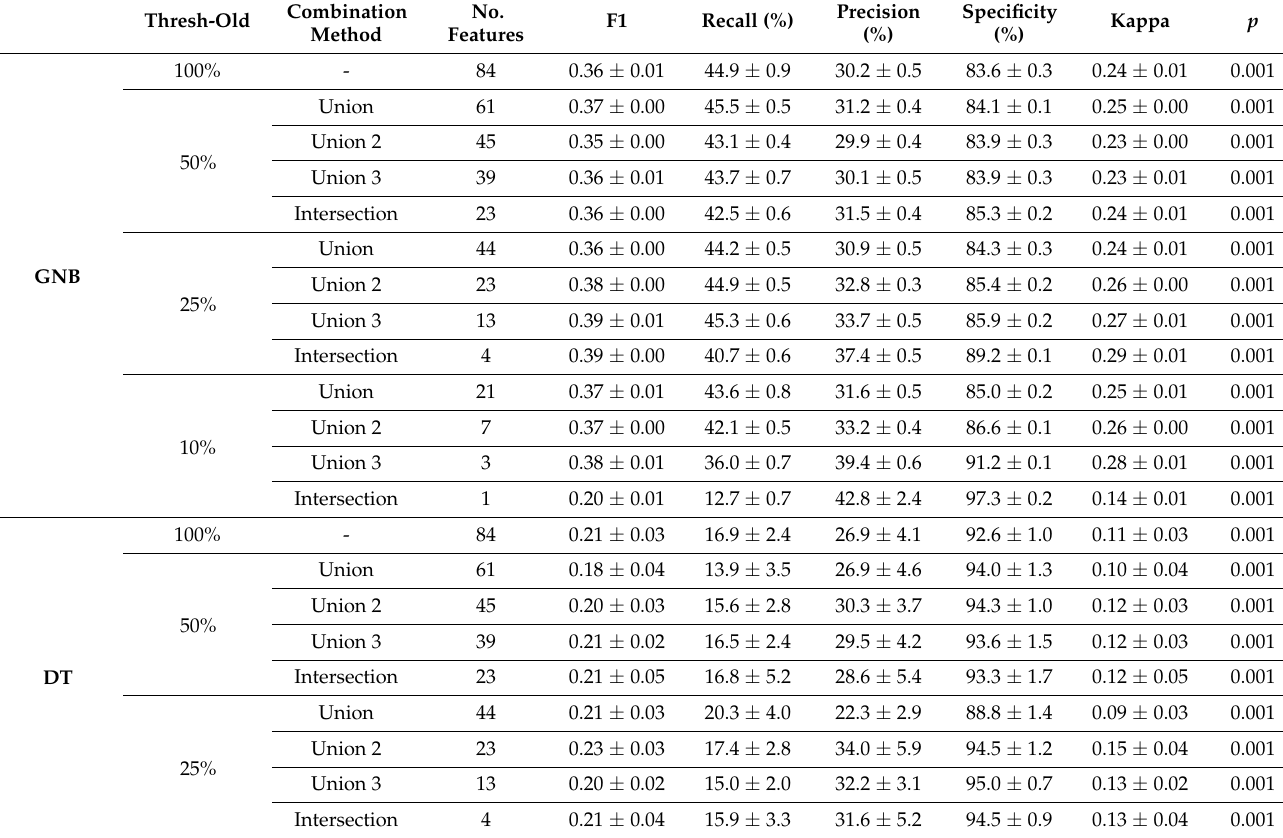
Table A8. Performance of the four classification models on detection fall using Mobility Lab Gait dual task walking data set ; Gaussian Naive Bayes (GNB); Decision Tree (DT); k-Nearest Neighbor (kNN); Support Vector Machine (SVM); p -value via permutation